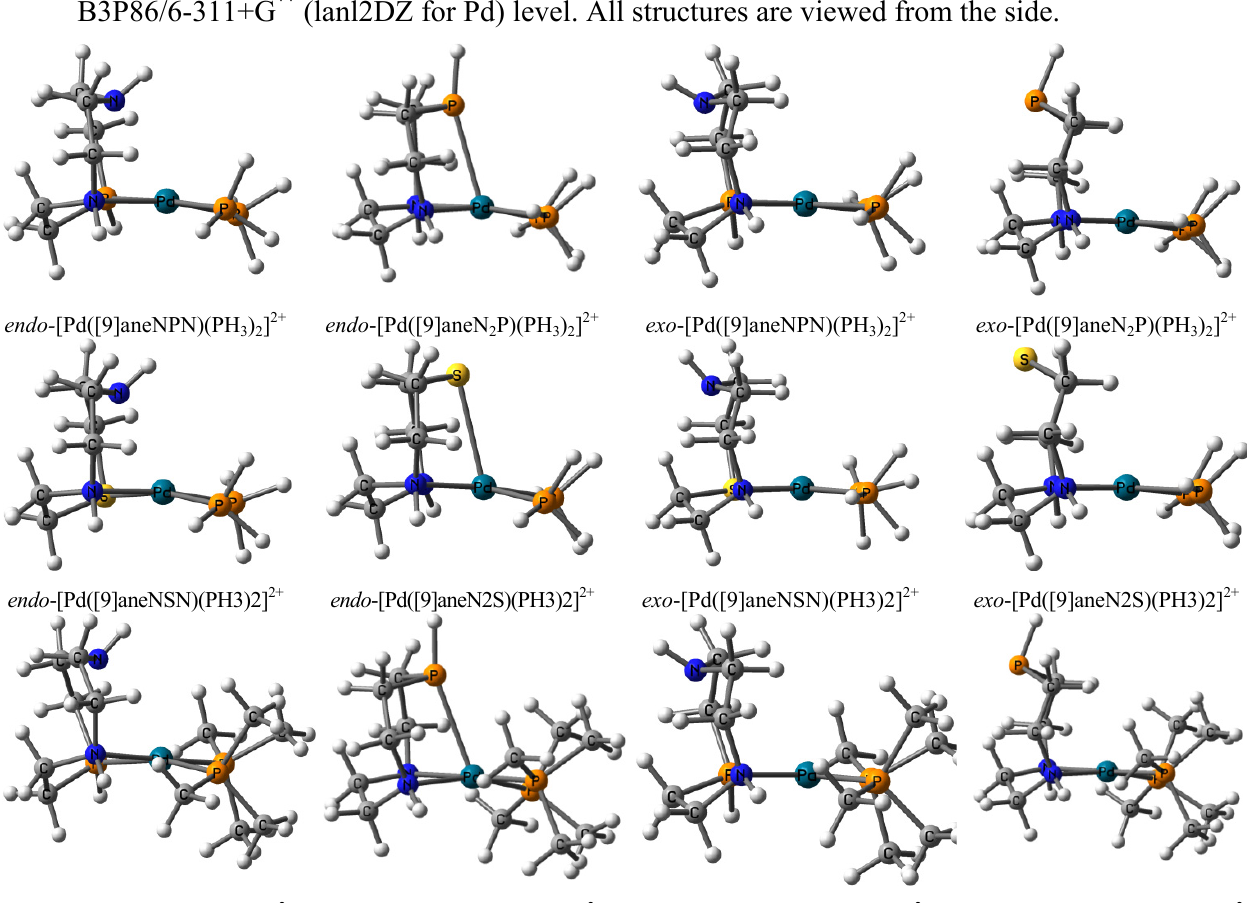
( A = P, S; B = N; L = PH 2